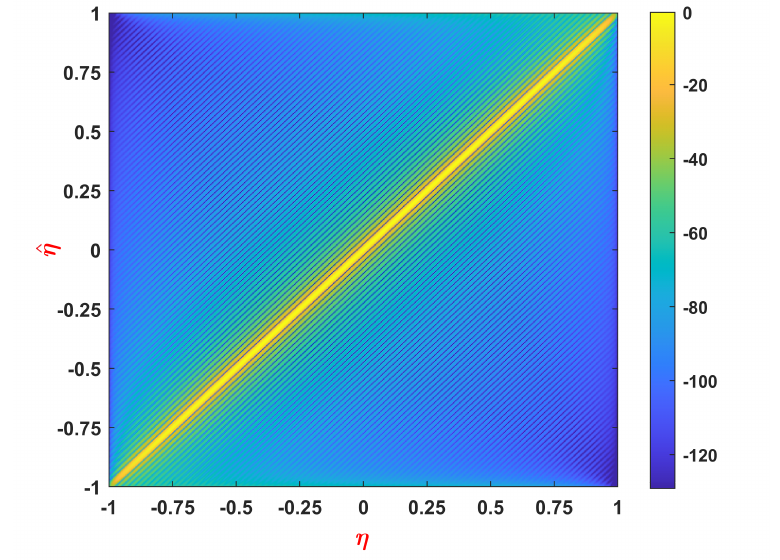
Figure 2. Actual kernel of A 1 A †